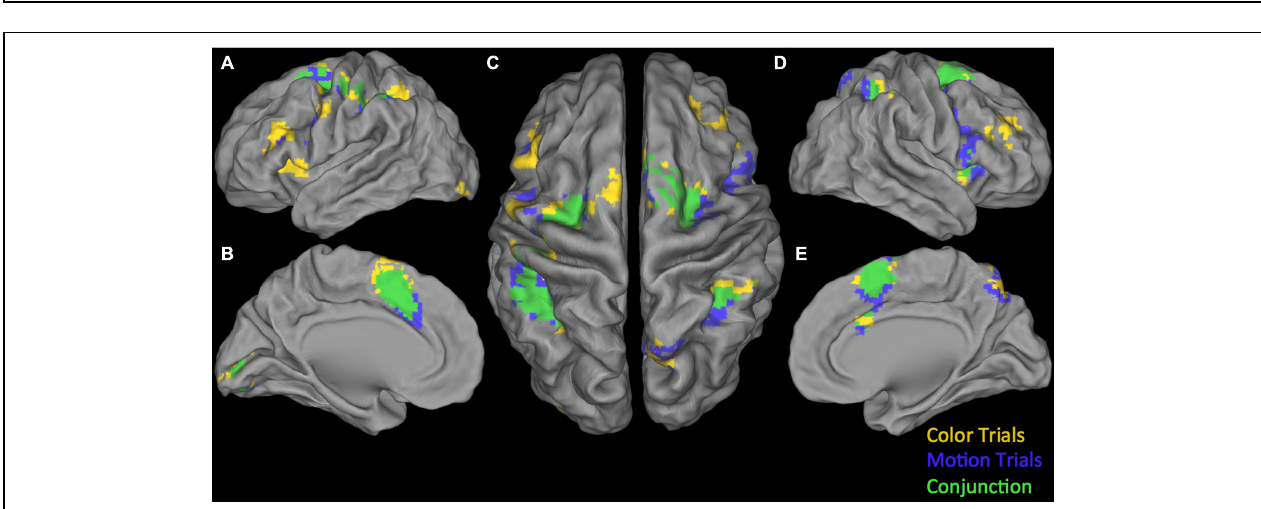
FIGURE 3 | Overview of positive parametric effects in color (yellow) and motion (blue) trials and their conjunction (green). (A) Lateral view of left Hemisphere, (B) Medial view of left Hemisphere, (C) Dorsal view, (D) Lateral view of right Hemisphere, and (E) Medial view of right Hemisphere. See Tables 2–4 for details.